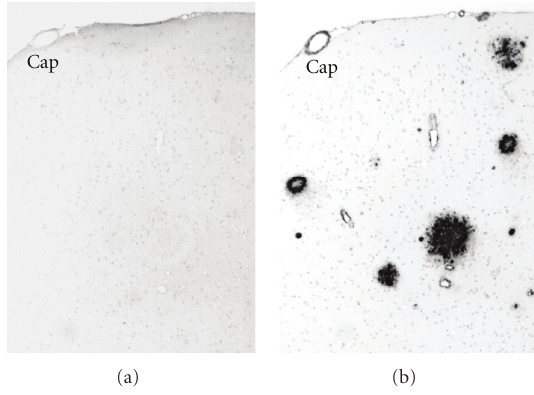
Figure 1: The labeling pattern of the anti-annular protofibril ( α APF) antiserum and anti-A β N-terminal pAb in serial sections of aged NEP − / − APP + mouse brain (embedded in para ffi n) by light microscopy. DAB method, 100x. Cap, capillary. (a) No immunoreaction (IR) for α APF antiserum was observed. (b) Anti- A β N-terminal pAb strongly labeled senile